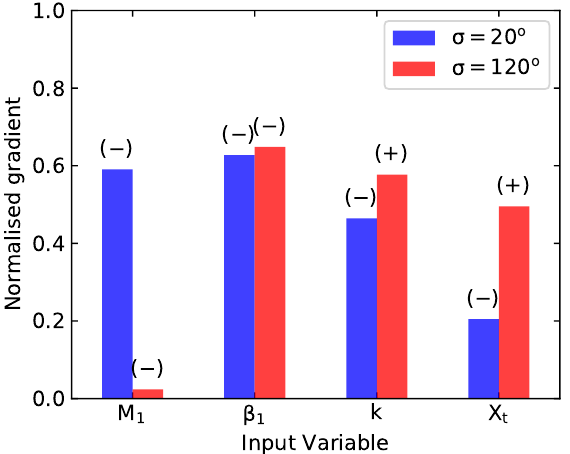
Figure 8. Normalised gradients for Case 4 at σ = 20 ◦ and σ = 120 ◦